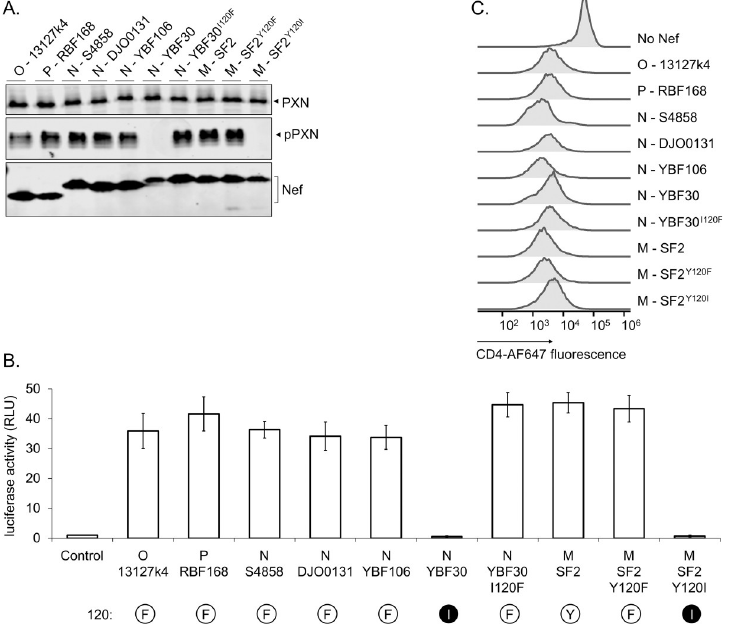
Fig 1. Hck-activating potential of selected HIV-1 Nefs. (A) Hck-expressing HZ-1 cells were co-transfected with vectors for paxillin and Nef from the indicated HIV-1 group M, N, O or P clones, or mutants thereof. Lysates of the transfected cells were analyzed by Western blotting using antibodies against paxillin (PXN), phosphorylated paxillin (pPXN) and Nef. (B) HZ-1 cells were transfected with an AP-1 transcription factor-driven luciferase reporter alone (Control) or together with the indicated Nefs variants. Luciferase activity was measured in cells harvested 24 h post- transfection, and normalized to the corresponding control sample that was set to 1. The data shown are derived from three independent experiments, with SE indicated by error bars. The amino acid at position 120 of each Nef protein is indicated, aromatic residues are shown as a black 1-letter symbol in a white sphere, and isoleucine as a white letter in a black sphere. (C) Jurkat T cells stably expressing CD4 were infected with lentiviral vectors expressing GFP alone (No Nef) or together with plasmids expressing the indicated Nefs. CD4 down-regulation by Nef was measured using flow cytometry 48 h after lentiviral transduction, and histograms illustrating cell surface levels of CD4 among the GFP positive Jurkat cells are shown. Original dot plots are shown in S1 Fig.